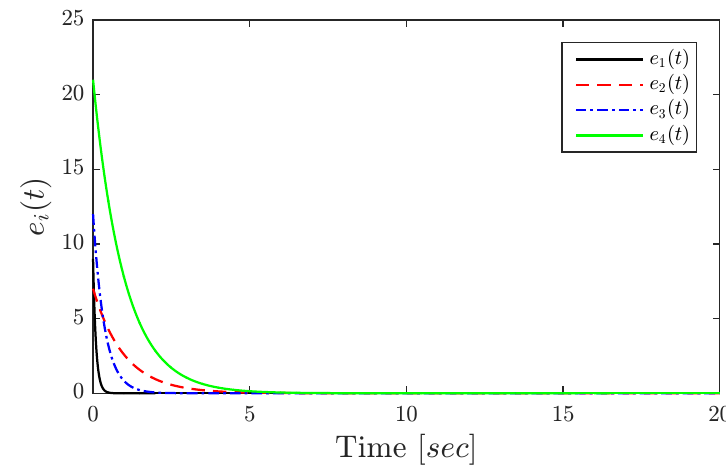
Figure 3. Time evolution of the synchronization error for the 4D case.